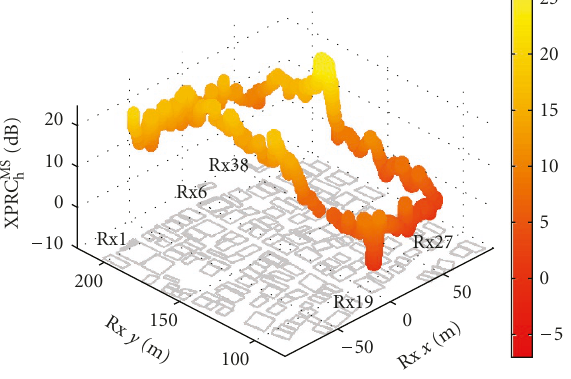
Figure 26: XPRC BS